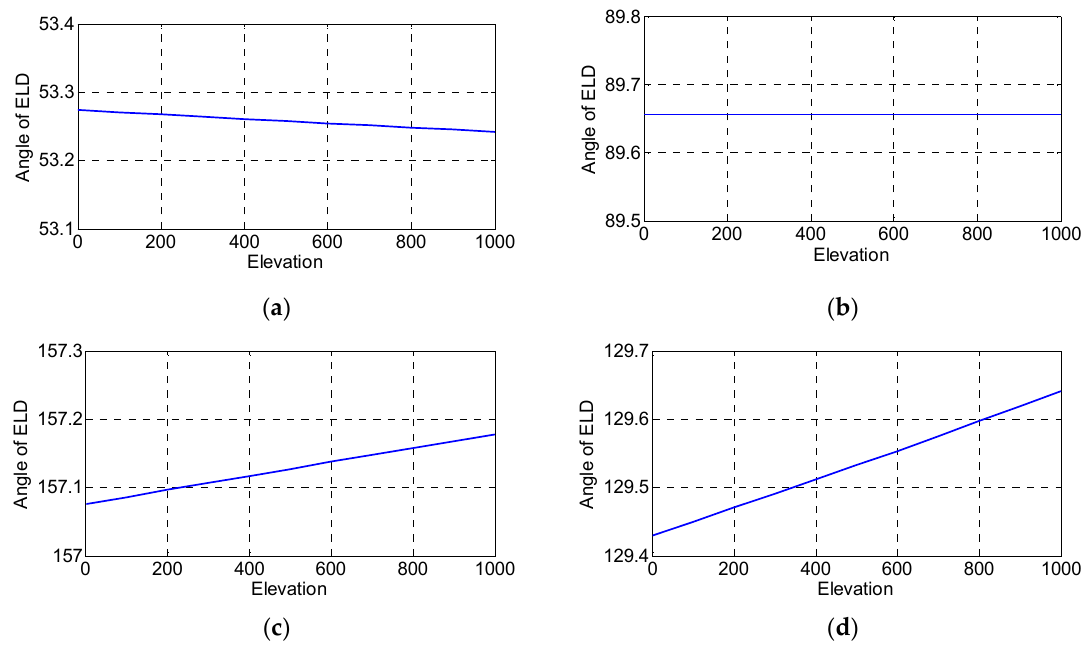
Figure 6. The θ c ~ H curves of: ( a ) a cross-track coplanar stereo image pair (JS-Z3N/JS-GF2-1); ( b ) an along-track stereo image pair (GD-Z3B/GD-Z3N-1); ( c ) a cross-track non-coplanar stereo image pair (SK-P1A/SK-W3-2); and ( d ) a CMDT stereo image pair (GD-Z3N-2/GD-IK-2).